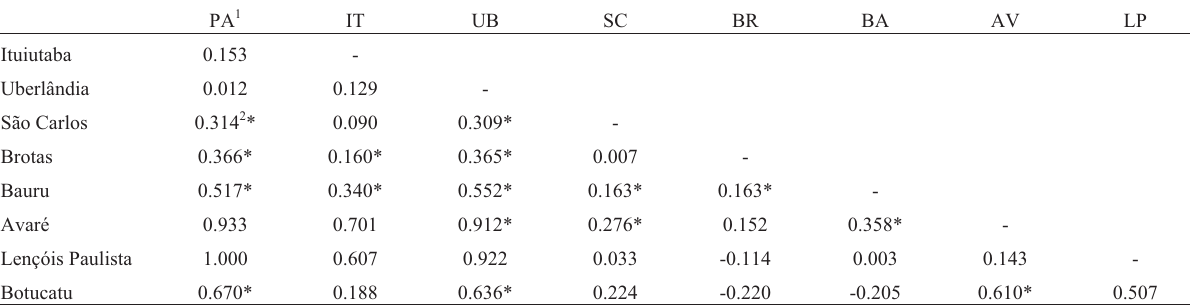
Table 2 - Indices of inter-population variation ( R ST ) for pairwise comparisons of the P. moratoi study